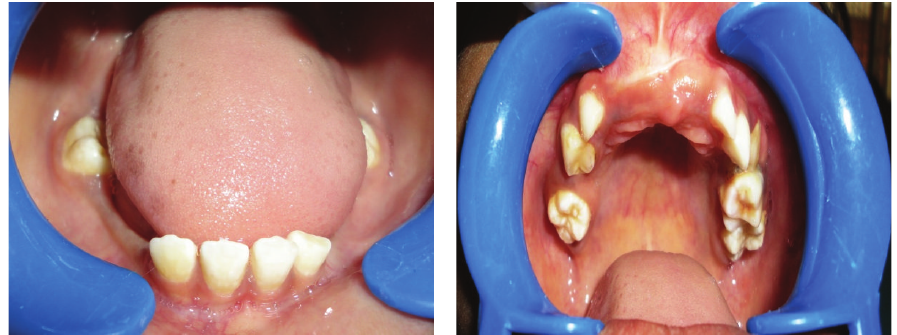
Figure 5: Showing missing teeth in relation to upper and lower anterior ends and mixed dentition.